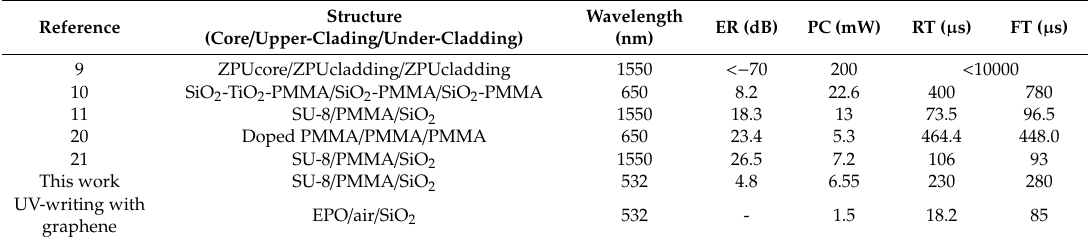
Table 1. Comparisons among the performances of this thermal optical switch and those of other reported polymer thermal optical